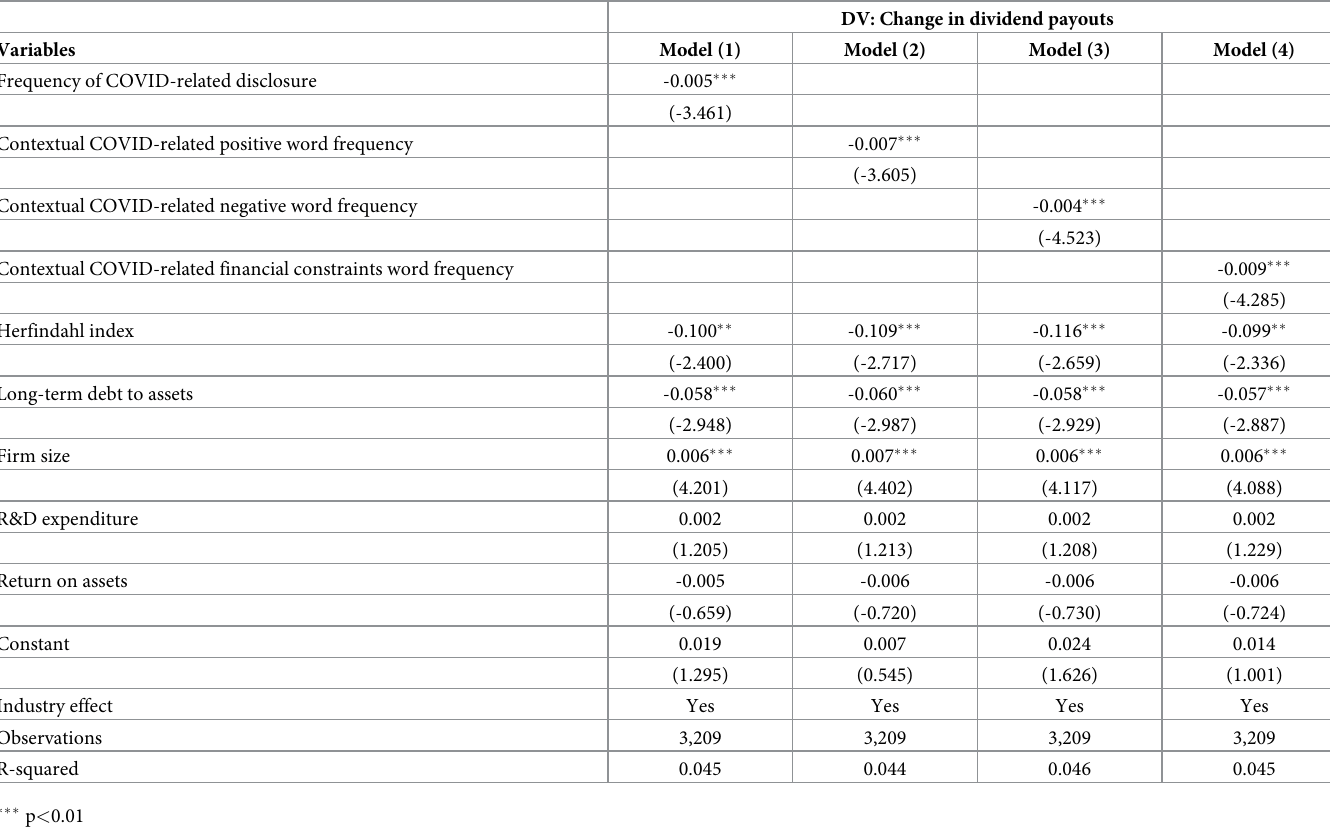
Table 6. Relationship between COVID-related disclosure and net change in dividend